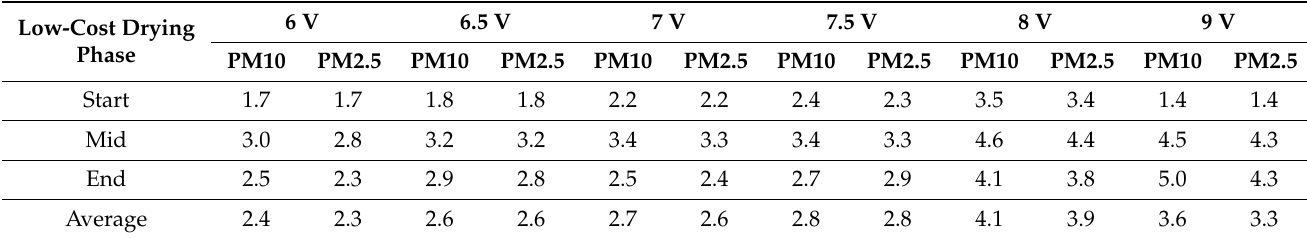
Table 2. PM concentration ratios of N3 to N3+dryer at different voltages.